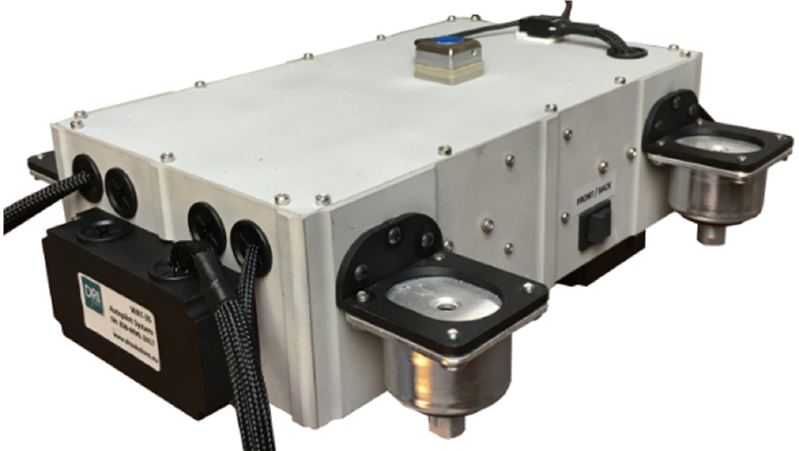
Figure 3. Autopilot installation.